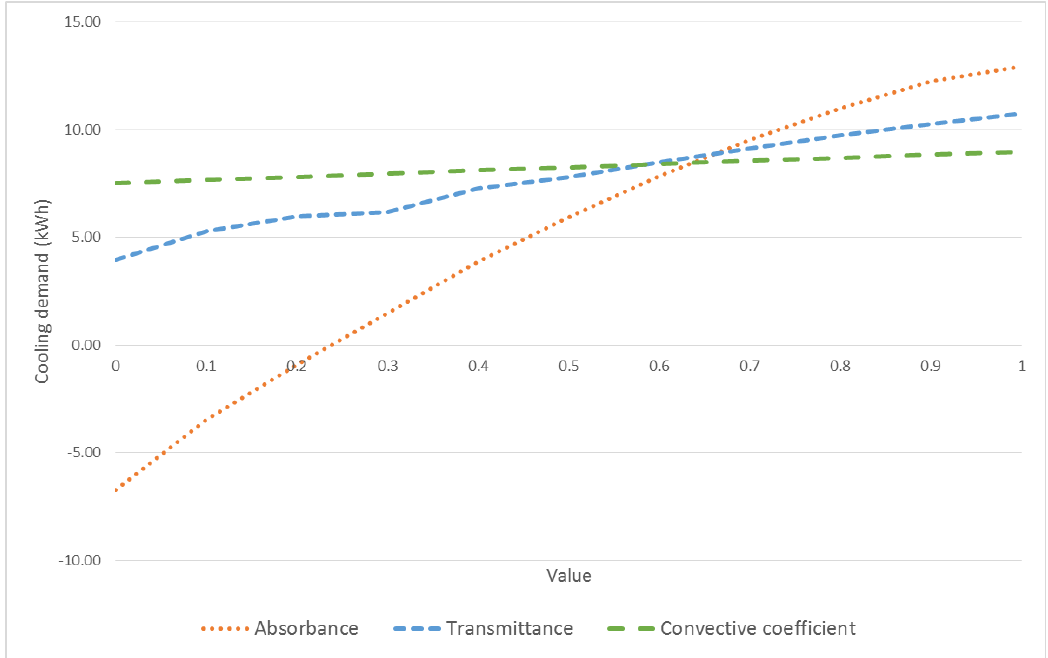
Figure 18. Sensitivity analysis of cooling demand varying thermal absorption, thermal transmittance, and convective heat transfer coefficient.